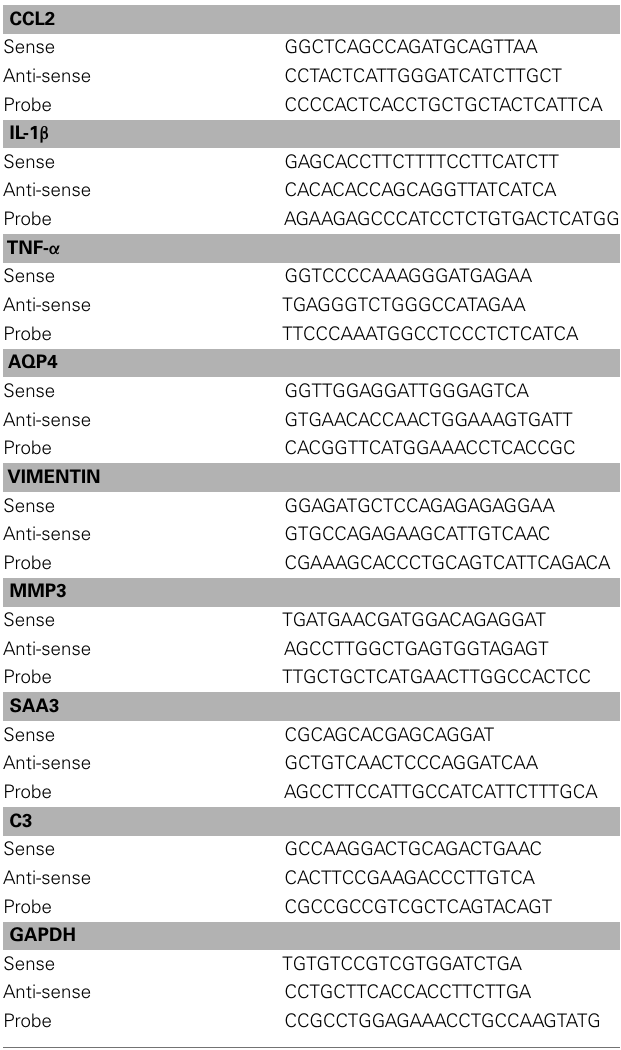
Table 1 | Real-time PCR